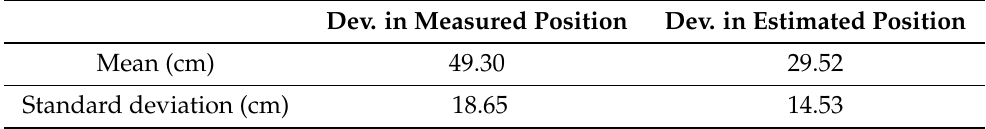
Table 1. Performance comparison between the GPS and the proposed method.